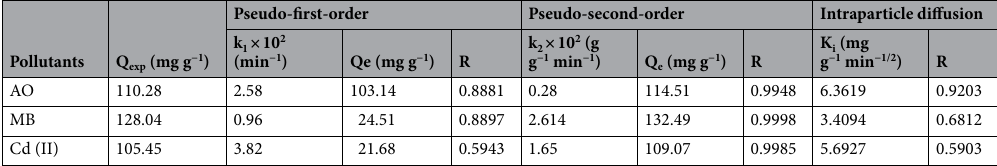
Pollutants Q exp (mg g −1